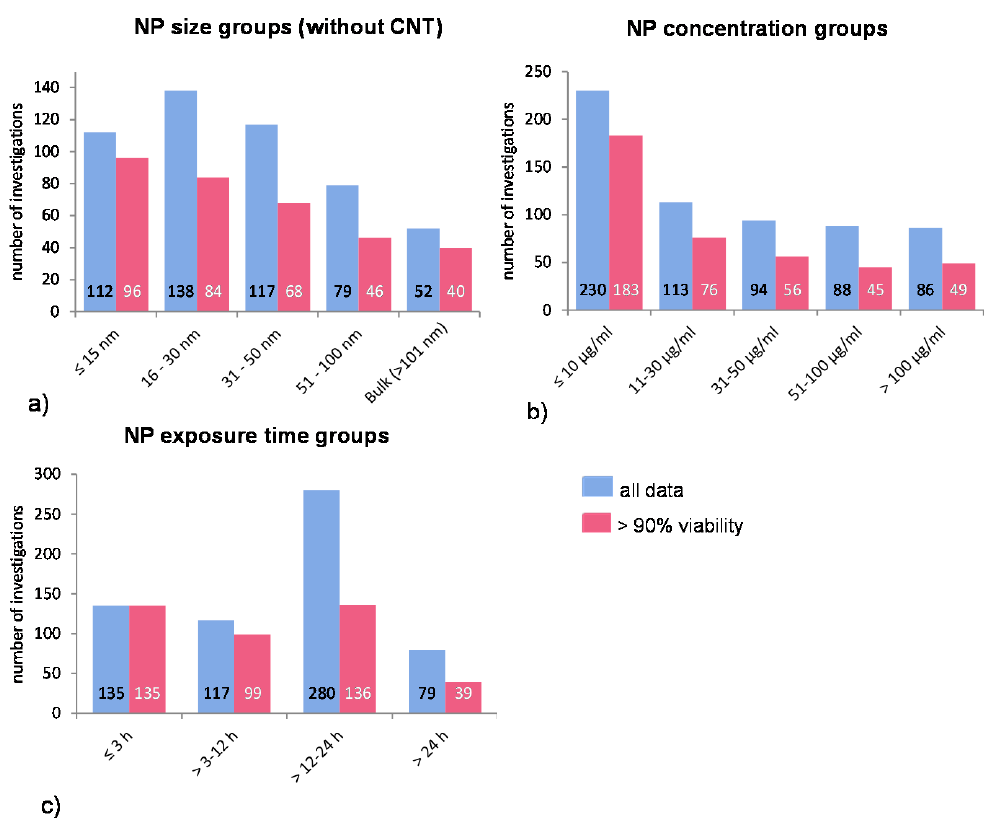
Table 2. Classification of data points into NP-size groups, NP-concentration groups and exposure time groups. If possible, each group contains at least five data points.